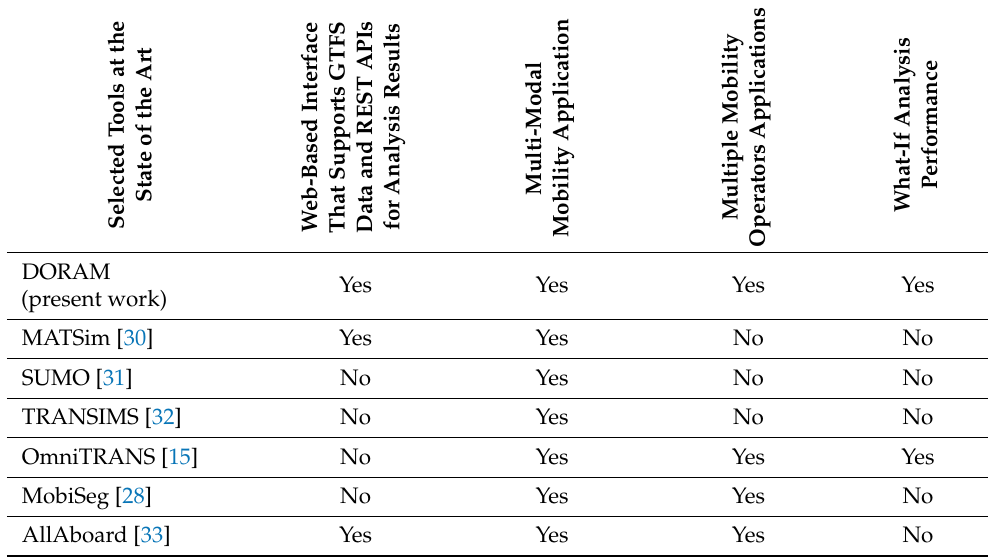
Table 1. Related works table focus on features tools at the state of